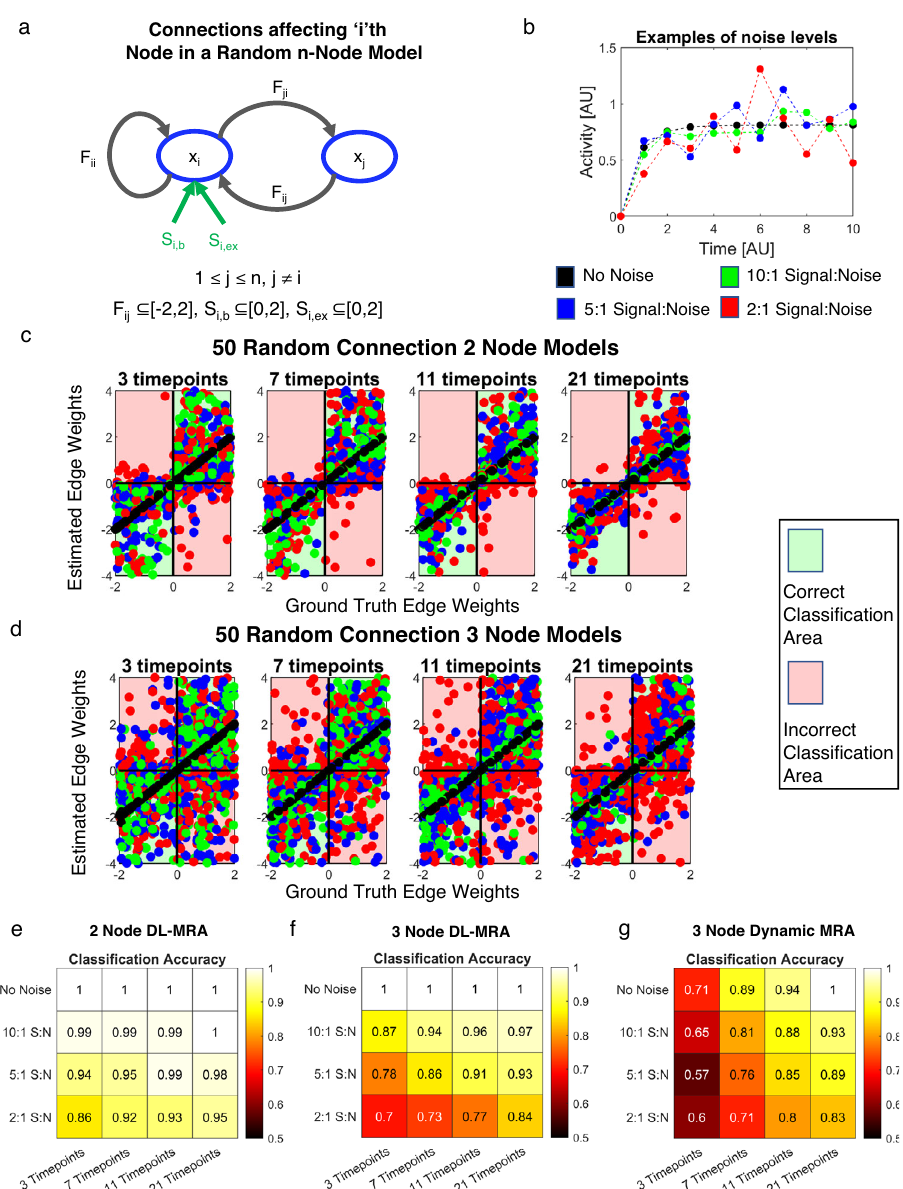
Fig. 2 Application to linear two and three node models. a Connections around a Node i in an n-Node Model. S i,b and S i,ex are the basal production and external stimulus terms acting on Node i , respectively. F ii is the self-regulation term; Fij the effect of Node j on Node i and F ji the effect of Node i on Node j . b Example of different signal-to-noise ratio effects on time course data. Ground truth versus estimated edge weights across all 50 random networks and noise levels for data from four different total timepoints (3,7,11,21) for 2 node ( c ) and 3 node ( d ) networks. Quadrant shading indicates edge classi fi cation. Fraction of network parameters correctly classi fi ed in 50 randomly generated 2 node networks ( e ) and 3 node networks ( f ) with different noise levels and total timepoints. g Fraction of network parameters correctly classi fi ed in 50 randomly generated 3 node networks with dynamic MRA using two sets of perturbation